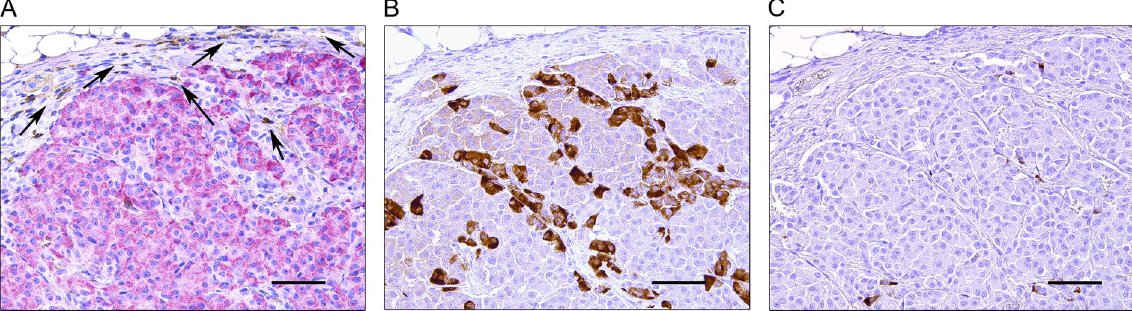
Figure 5. Long-term preservation of beta cell function in HU-SRC-SCID mice transplanted with LEA29Y expressing NPICCs. Xenograft was harvested 29 weeks post transplantation and stained for ( A ) human CD45 (brown) and insulin (red), ( B ) glucagon (brown) and ( C ) somatostatin (brown). Local LEA29Y expression preserved ICC structure and restricted human immune infiltration to the periphery of the transplantation site. Scale bar: 100 μ